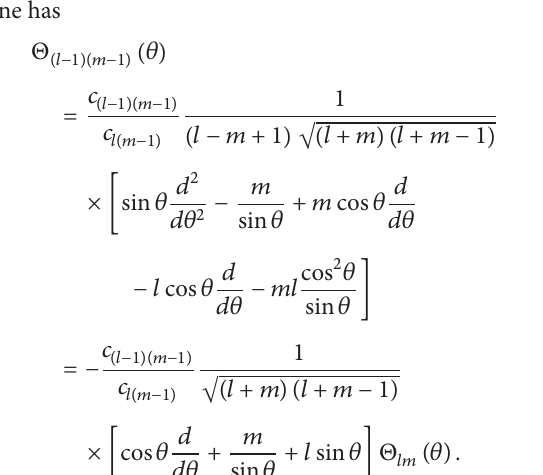
Figure 3: Different-radius spherical wells constructed by shift operators for 𝑙 = 0 case illustrated in cross